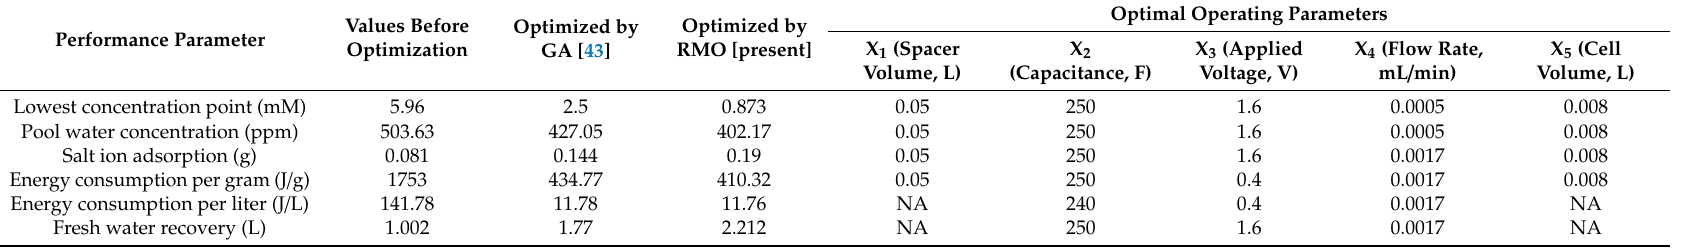
Table 5. Results of the single objective based optimization for multiple constrained operating parameters.